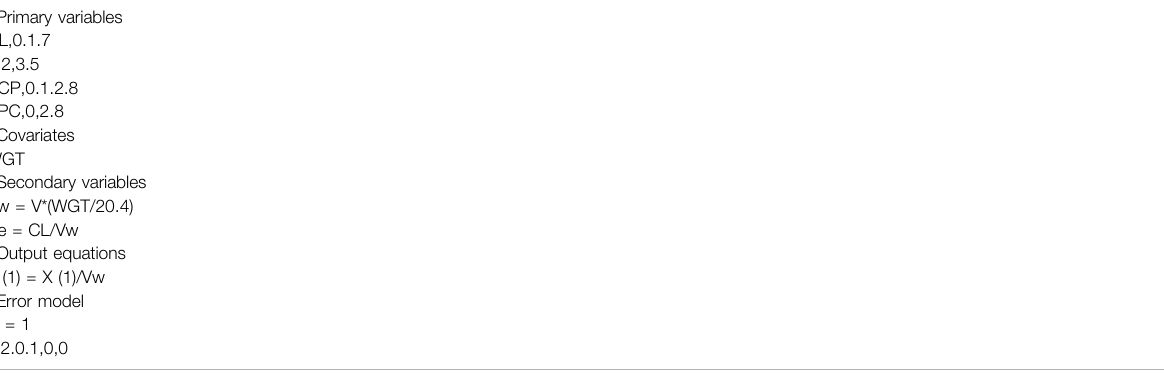
TABLE 3 | Pmetrics model for the fi nal covariate model for meropenem. #Primary variables CL,0.1.7